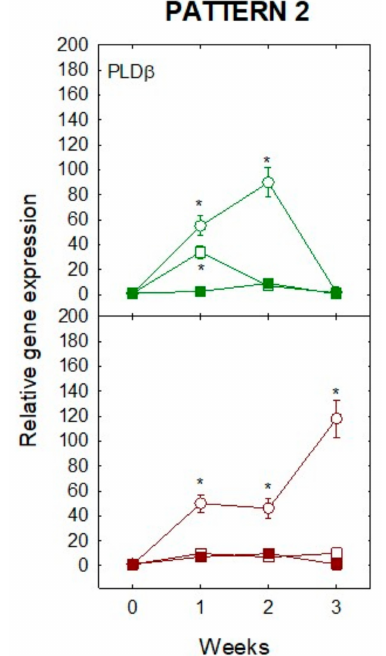
Figure 5. E ff ect on relative gene expression of di ff erent conditions of water stress (severe drought (0% ET, O), mild drought (50% ET, (cid:3) ), and fully watered plants (100% ET, (cid:4) )) in leaves (upper panel) and roots (lower panel) of ‘Pineapple’ sweet orange trees during a 3-week period. Pattern 2: Expression of CsPLD β . Data are means ± SE of three biological replicates. Asterisks indicate significant di ff erences at * p <